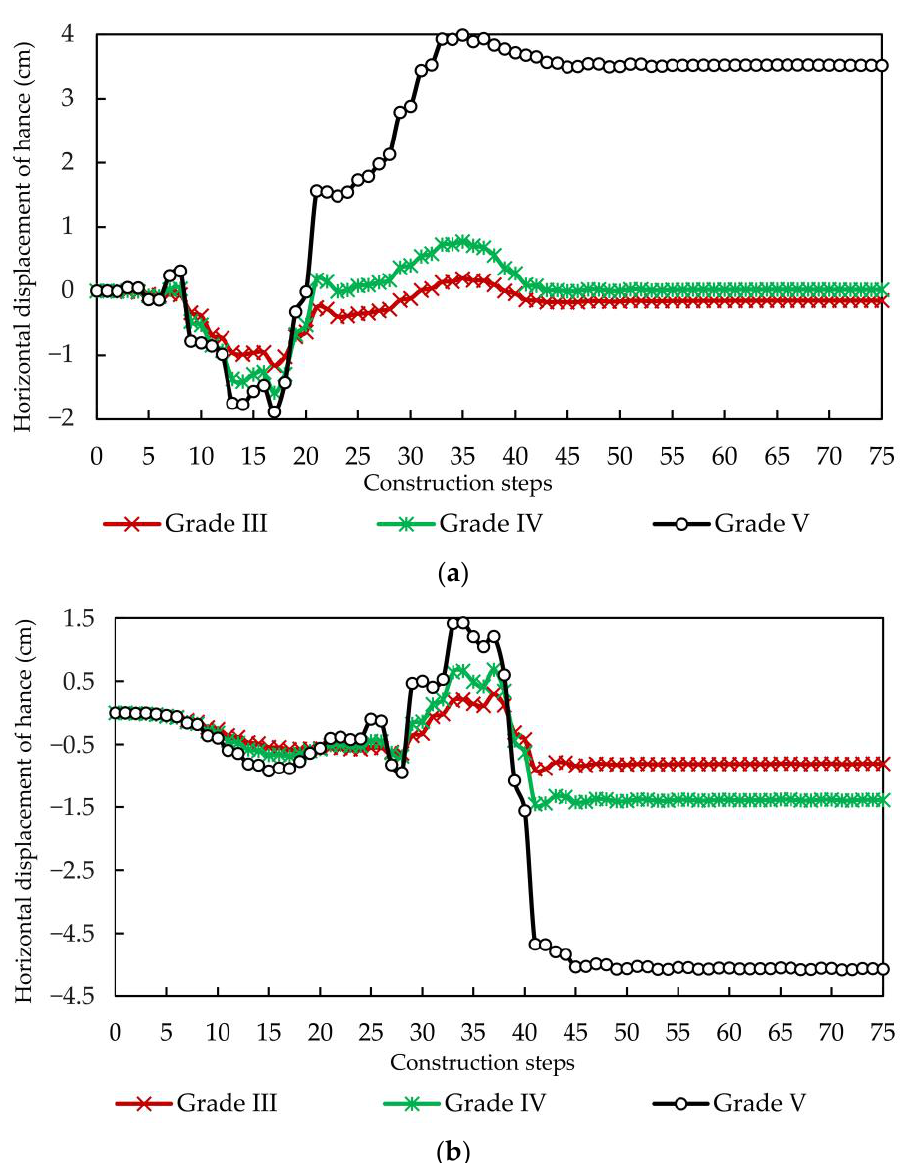
Figure 14. Variation curves of hance horizontal displacement under different lithology grades: ( a ) Main line tunnel; ( b ) Ramp.